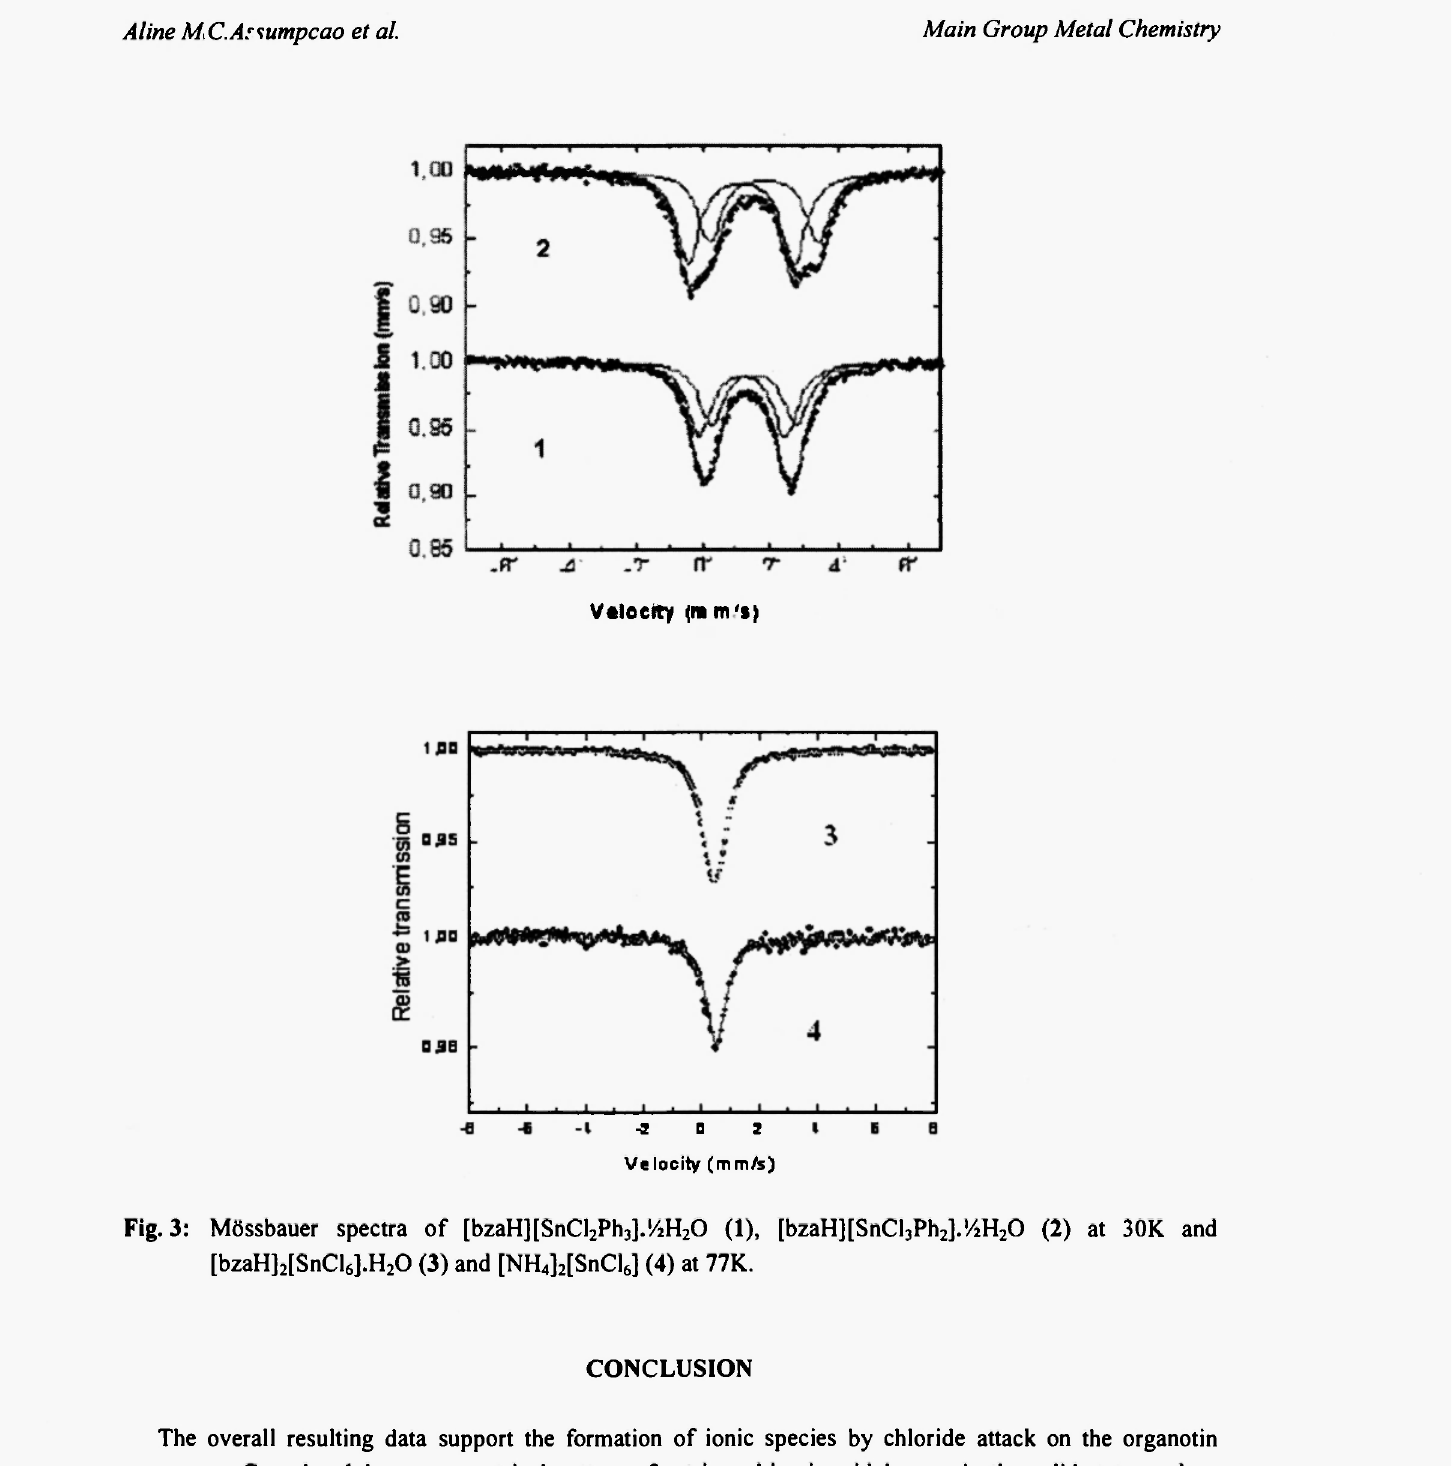
Fig. 3: Mössbauer spectra of [bzaH][SnCI 2 Ph 3 ].!/2H 2